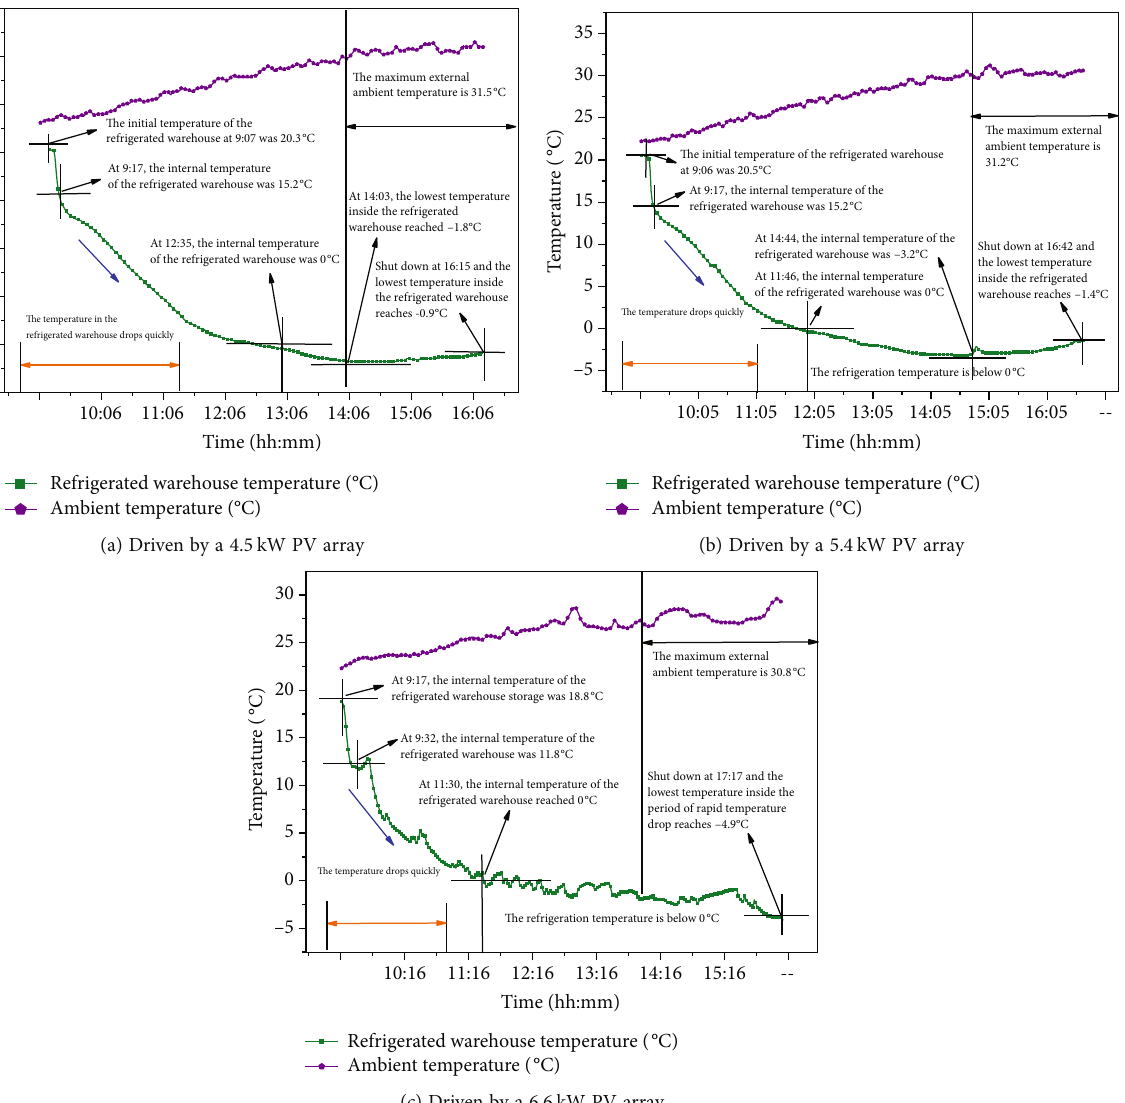
Figure 4: Variation of ambient temperature and storage temperature under di ff erent PV